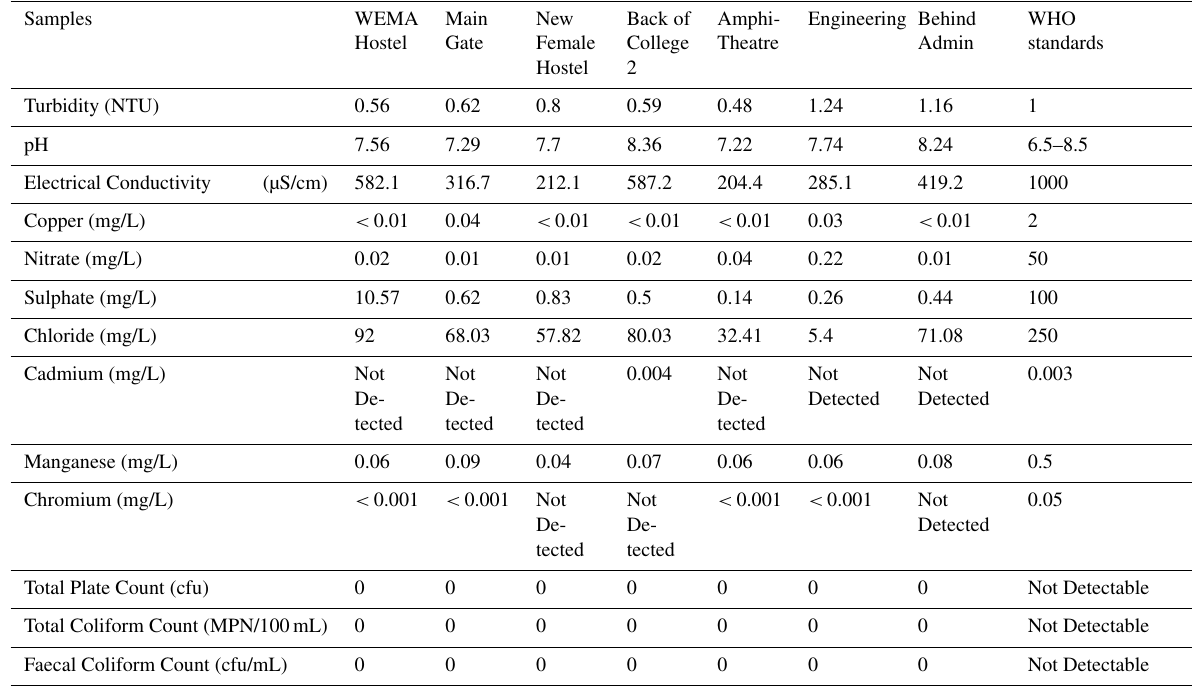
Table 2. Quality parameters for samples from boreholes. Samples